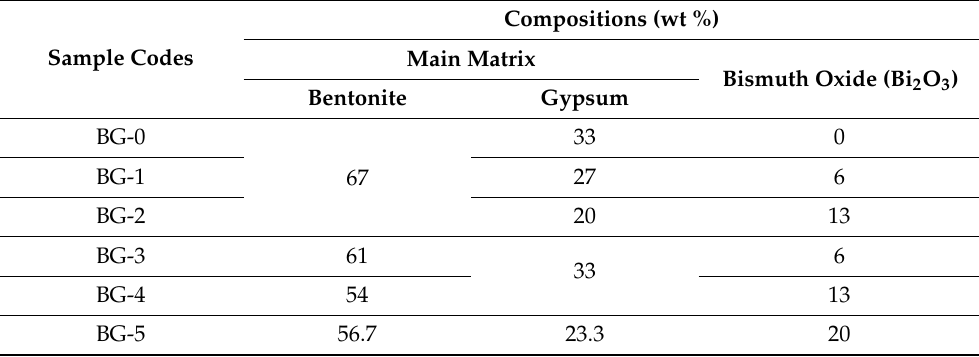
Table 2. The sample codes and the weight fraction in percentage (wt%) of bentonite, gypsum, and Bi 2 O 3